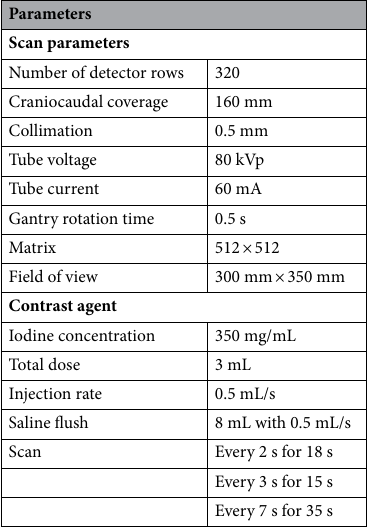
Table 1. Parameters of perfusion CT. The first scan occurred 6 s after initiating the contrast agent